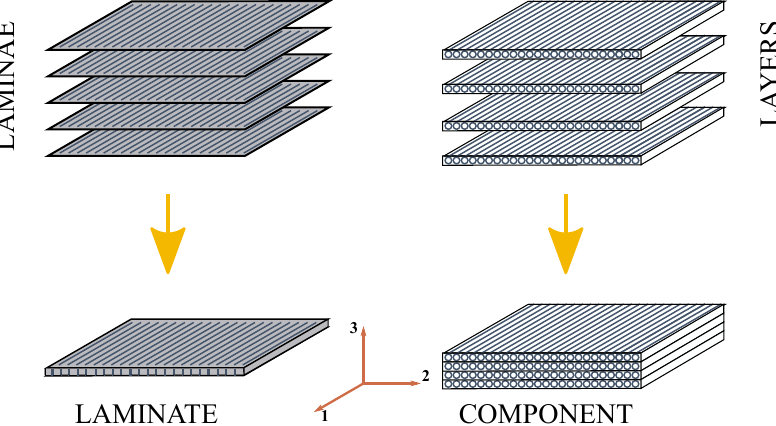
Figure 4. Comparison between unidirectional laminae, stacked into a laminate, and FFF layers, piled into a component with a linear